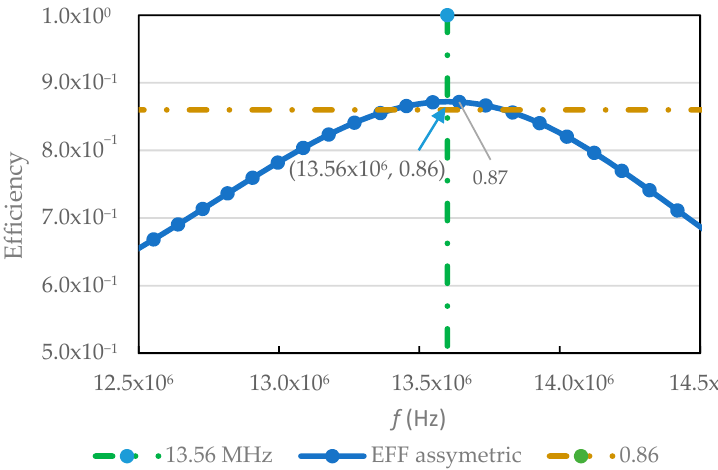
Figure 16. Efficiency in asymmetric S-CPT system with internal resistance.